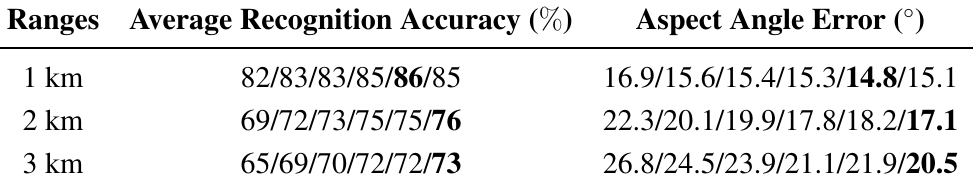
representation-based classification (SRC)/multi-attribute Lasso with group constraint